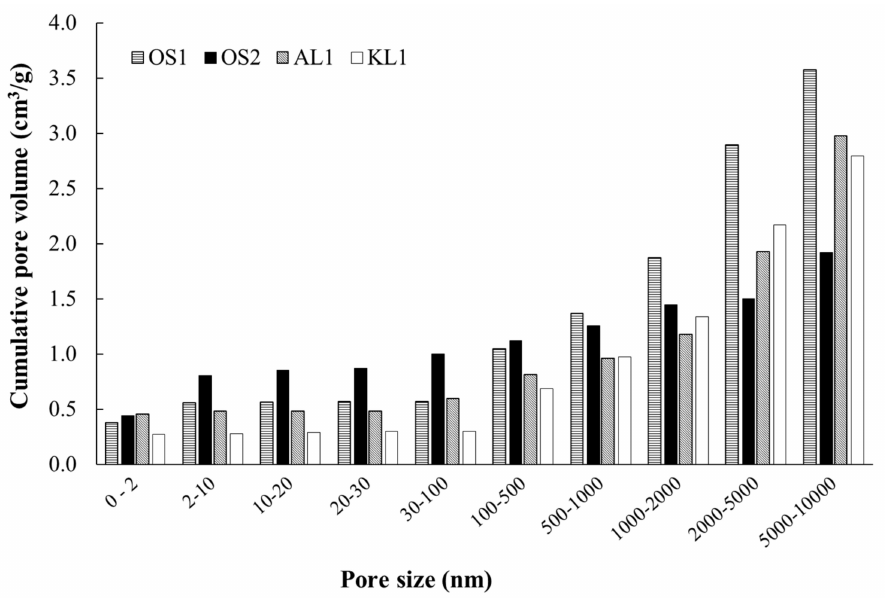
Figure 3. Cumulative pore volume of the ACMs catalysts derived from both the N 2 adsorption-desorption at − 196 ◦ C (micropore and mesopore range) and Hg porosimetry (macropore